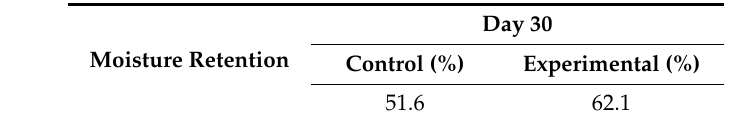
Table 6. Average moisture retention effect of 20 subjects using the butterfly pea flower hot spring water mask.